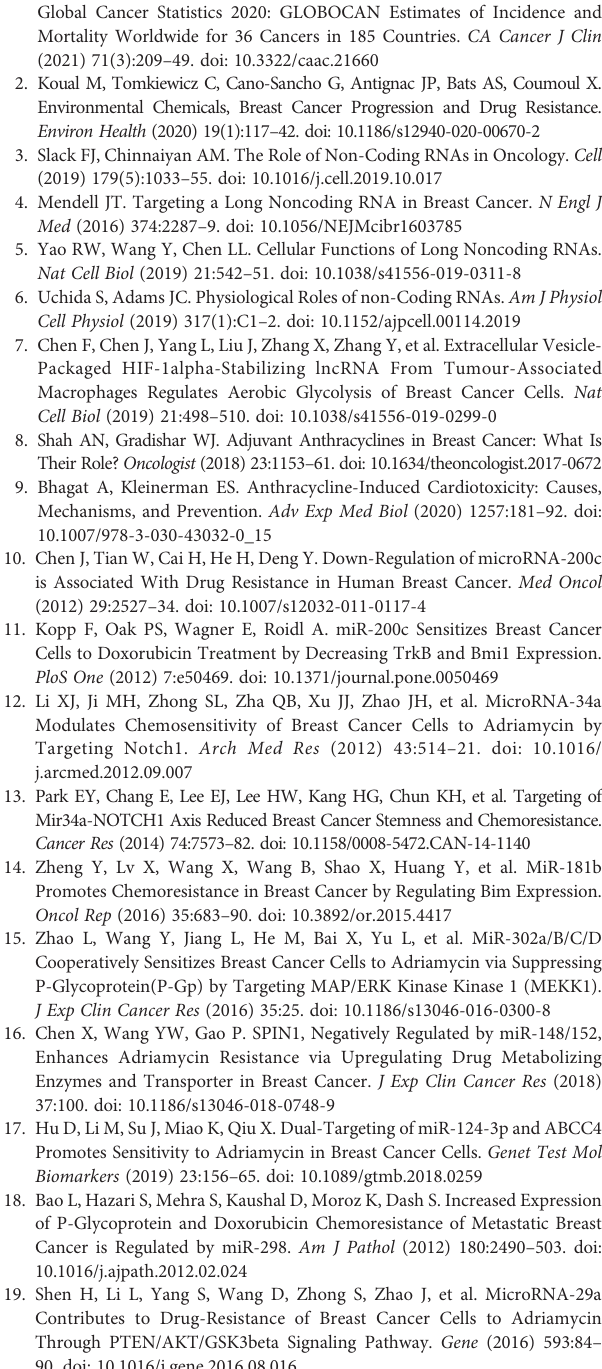
Supplementary Figure 5 | The pattern diagram of ncRNAs and Fluorouracil chemoresistance. Supplementary Figure 6 | The pattern diagram of ncRNAs and Trastuzumab